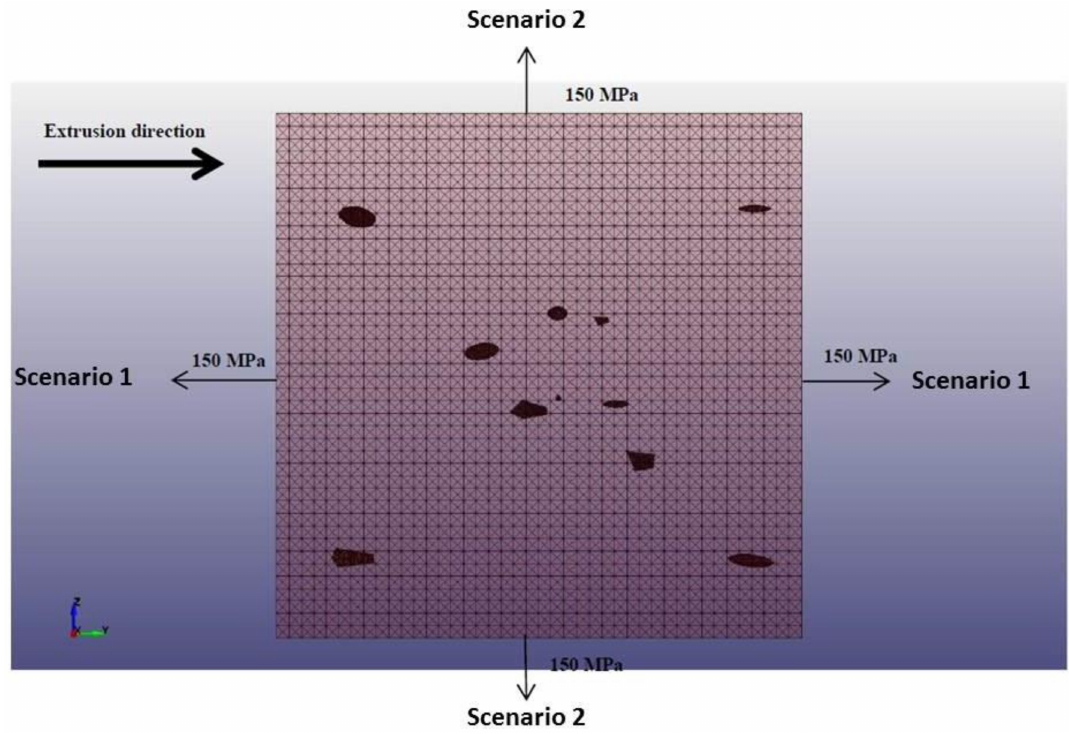
Figure 4. Loading scenarios: Load aligned with the extrusion direction (Scenario 1) or transverse to the extrusion direction (Scenario 2), (Top view). Each scenario was separately